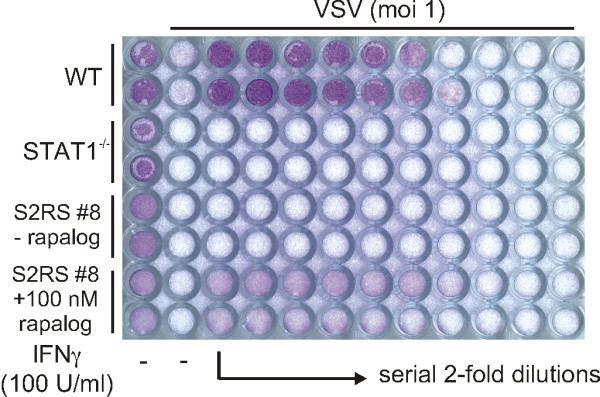
Rapalog-induced antiviral activity in IFNγ-treated MEF cell lines. Cells were treated with 100 nM rapalog for 4 h or left untreated and subsequently stimulated with serial two-fold dilutions of IFNγ (starting with 100 U/ml) for 8 h or left untreated. Cells were then challenged with VSV (moi = 1) and surviving cells were stained with crystal violet 36 h post infection.